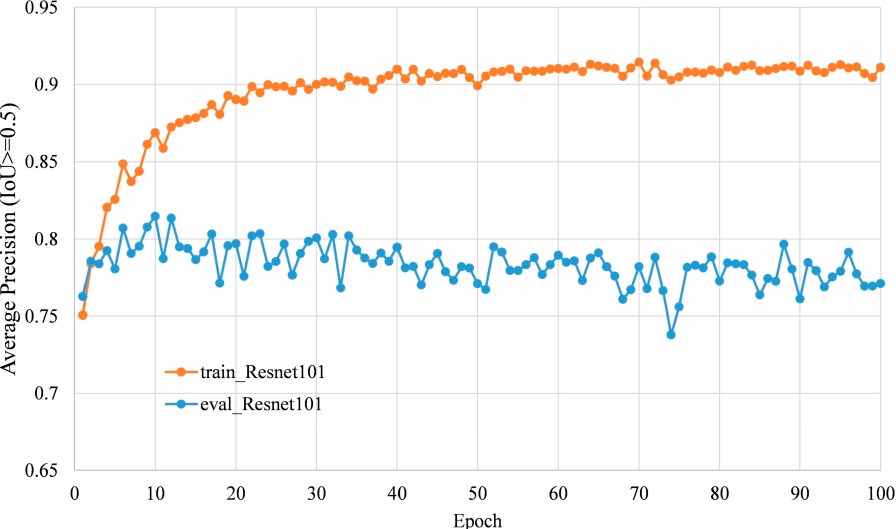
Figure 10. Change in average precision (AP) at an intersection of union (IoU) threshold of 0.5 of training data and validation data using Resnet 101 with the